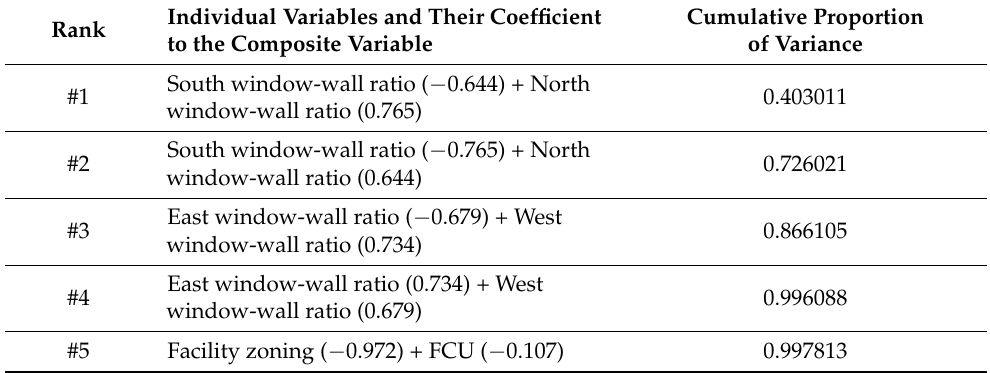
Figure 2. Decision support models by k-means ( left ) and SOM ( right ).